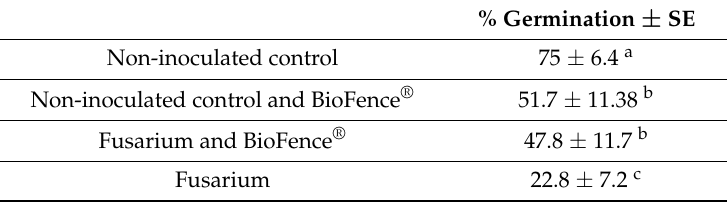
Table 3. Percentage of germination of the P. radiata seeds inoculated with F. circinatum isolates, FcCa1 and Fc015, and treated with BioFence ® . Different letters in the column indicate significant differences ( p < 0.05), according to Tukey’s post-hoc